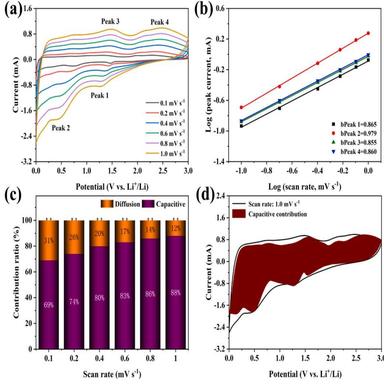
FeSnSe/SCNFs-1 electrode (a) CV curves at 0.1 to 1.0 mV s − 1 sweep rates; (b) linear relationship between the corresponding log ip-log (v); (c) diffusive contribution versus pseudocapacitive contribution histograms at various sweep rates; (d) pseudocapacitive contribution CV curves at 1.0 mV s − 1 sweep rate.